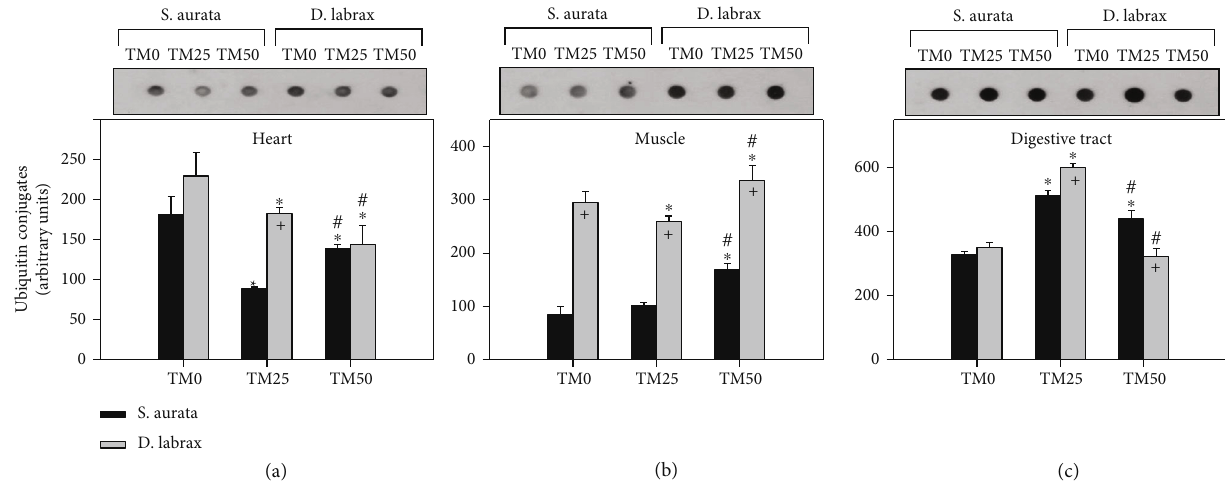
Figure 4: Ubiquitin conjugates in the heart (a), muscle (b), and digestive tract (c) of gilthead sea bream ( S. aurata ) and European sea bass ( D. labrax ) under the 0% (TM0), 25% (TM25), and 50% (TM50) T. molitor inclusion diet treatment. Representative immunoblots are shown and were quanti fi ed by laser scanning densitometry and plotted. Values represent means ± SD ; n = 5 preparations from di ff erent animals. ∗ indicates p < 0 : 05 compared with 0%, # indicates p < 0 : 05 compared with 25%, and + indicates p < 0 : 05 between species at the same TM